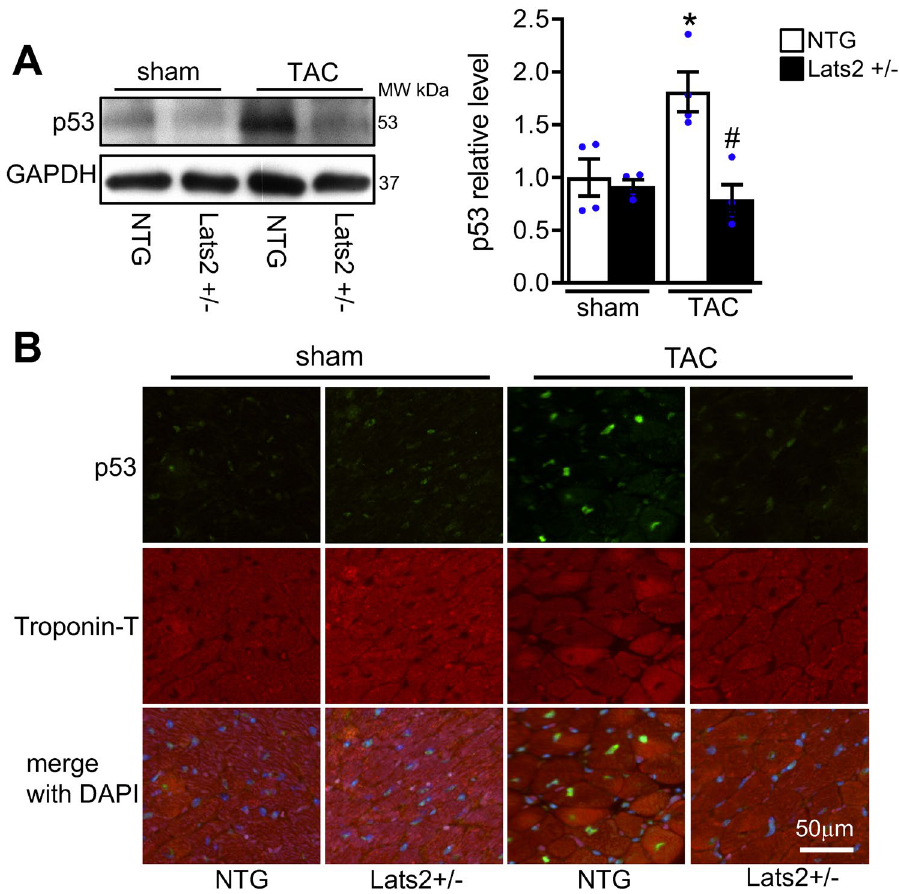
Figure 5. The role of Lats2 in mediating p53 in the heart during pressure overload. Non-transgenic (NTG) and Lats2 +/- mice were subjected to either transverse aortic constriction (TAC) or sham operation for 4 weeks. ( A ), The levels of p53 and GAPDH were evaluated with immunoblot analyses. Representative images (left) and quantification (right) are shown. * p < 0.05 versus NTG mouse hearts with sham operation. # p < 0.05 versus NTG mouse hearts with TAC for 4 weeks. ( B ), The level of p53 in the heart was evaluated by immunostaining with anti-p53 antibody and anti-troponin-T antibody, the latter of which identifies cardiomyocytes. Representative images are